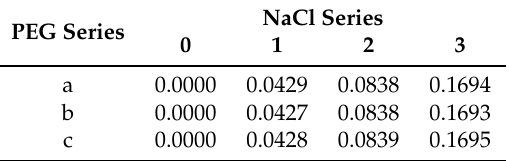
Table 9. Molalities of sodium chloride (moles of NaCl per kg of water) in solutions used in